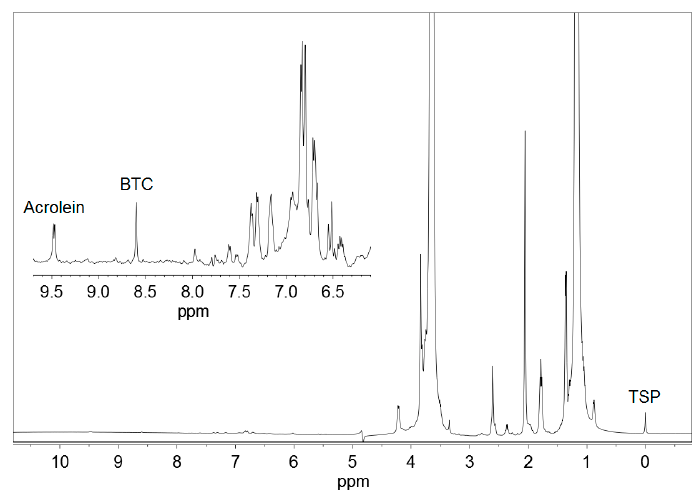
Figure 1. 1 H NMR spectrum of a standard for calibration containing 35.1 mg/L acrolein, 1,3,5-benzenetricarboxylic acid (BTC) and 3-(trimethylsilyl)-2,2,3,3-tetradeuteropropionic acid sodium salt (TSP). An expansion of the working region is shown.